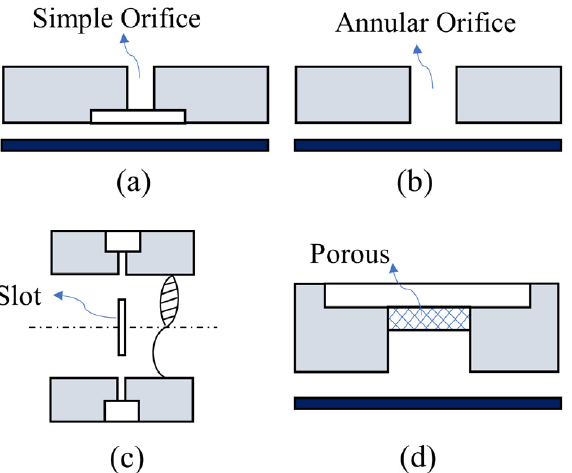
Figure 8. Various types of restrictors. ( a ) orifice restrictor ( b ) annular restrictor ( c ) slot restrictor ( d ) porous restrictor.